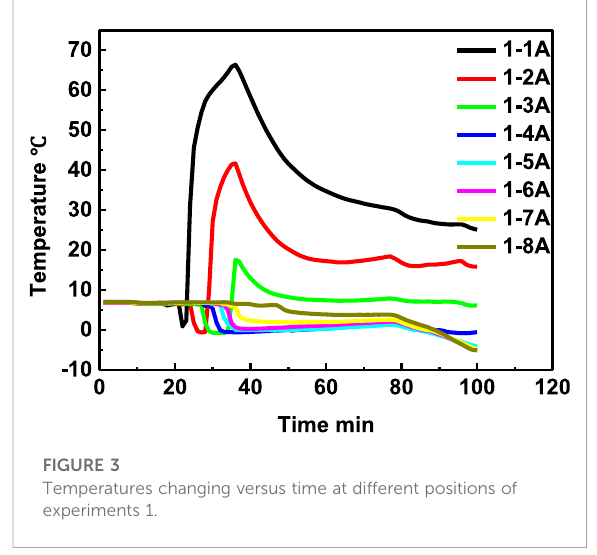
FIGURE 3 Temperatures changing versus time at different positions of experiments 1.